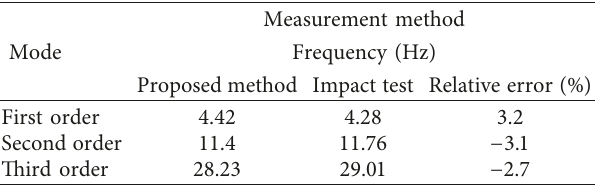
Table 1: The recognition results of blade’s modal frequencies.